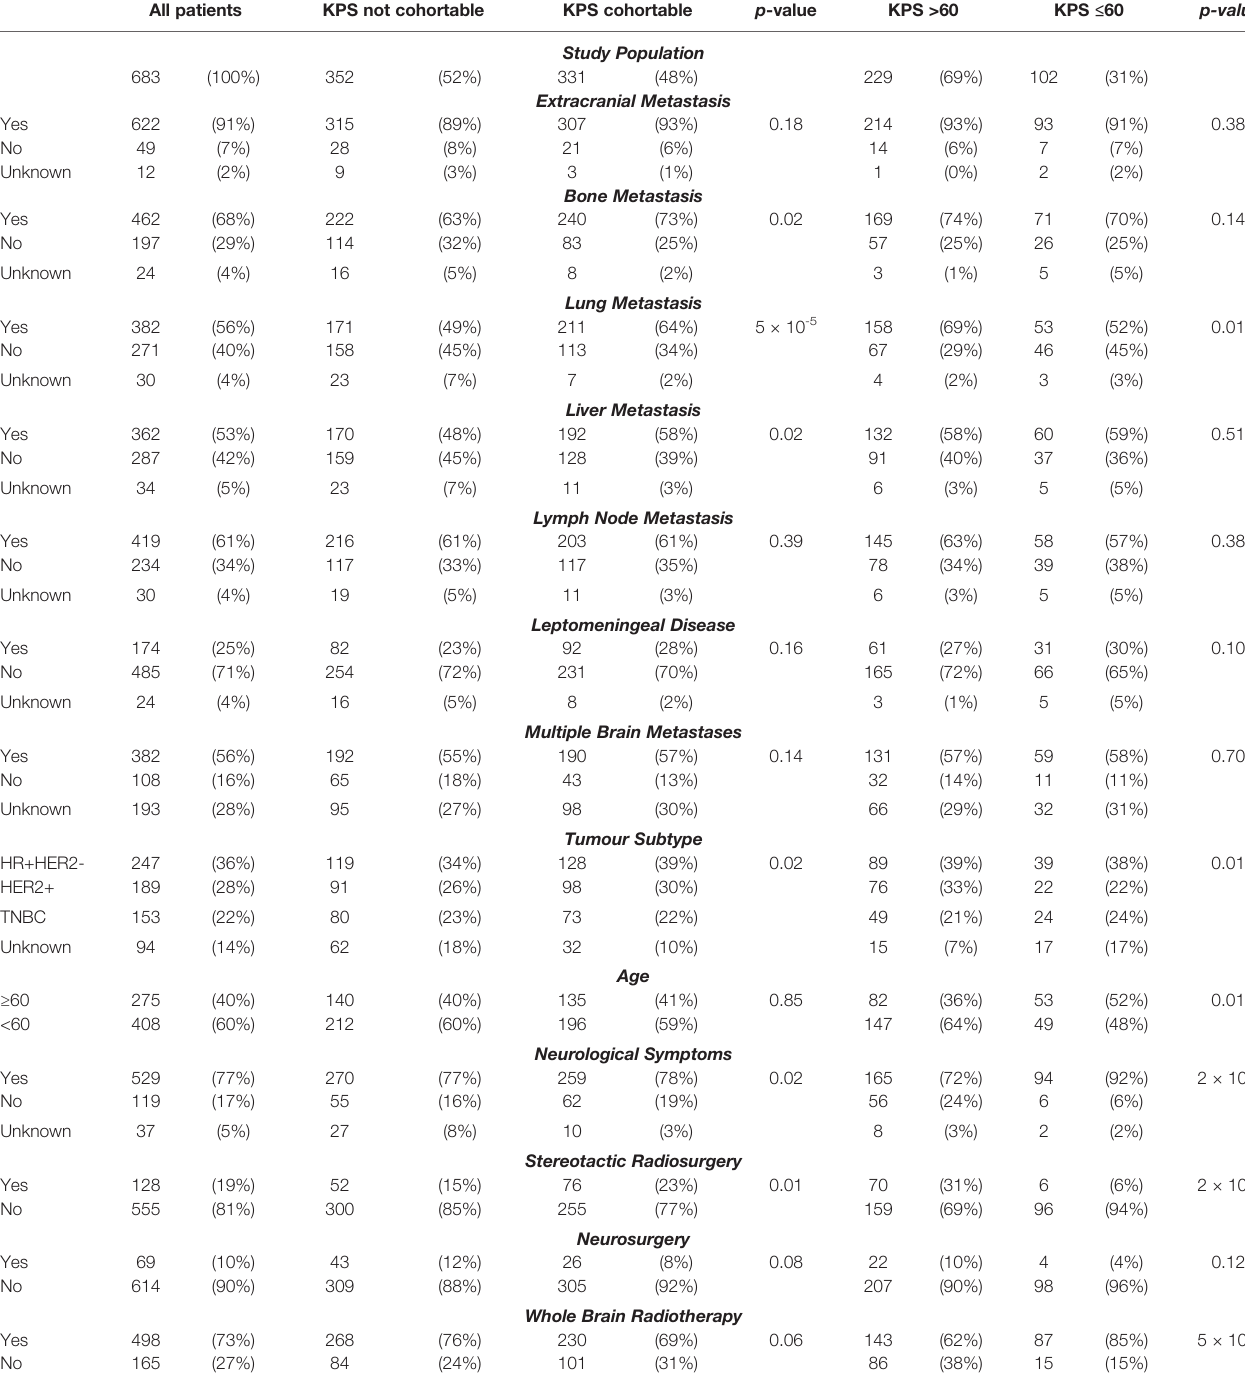
TABLE 1 | Characteristics of the study population. All